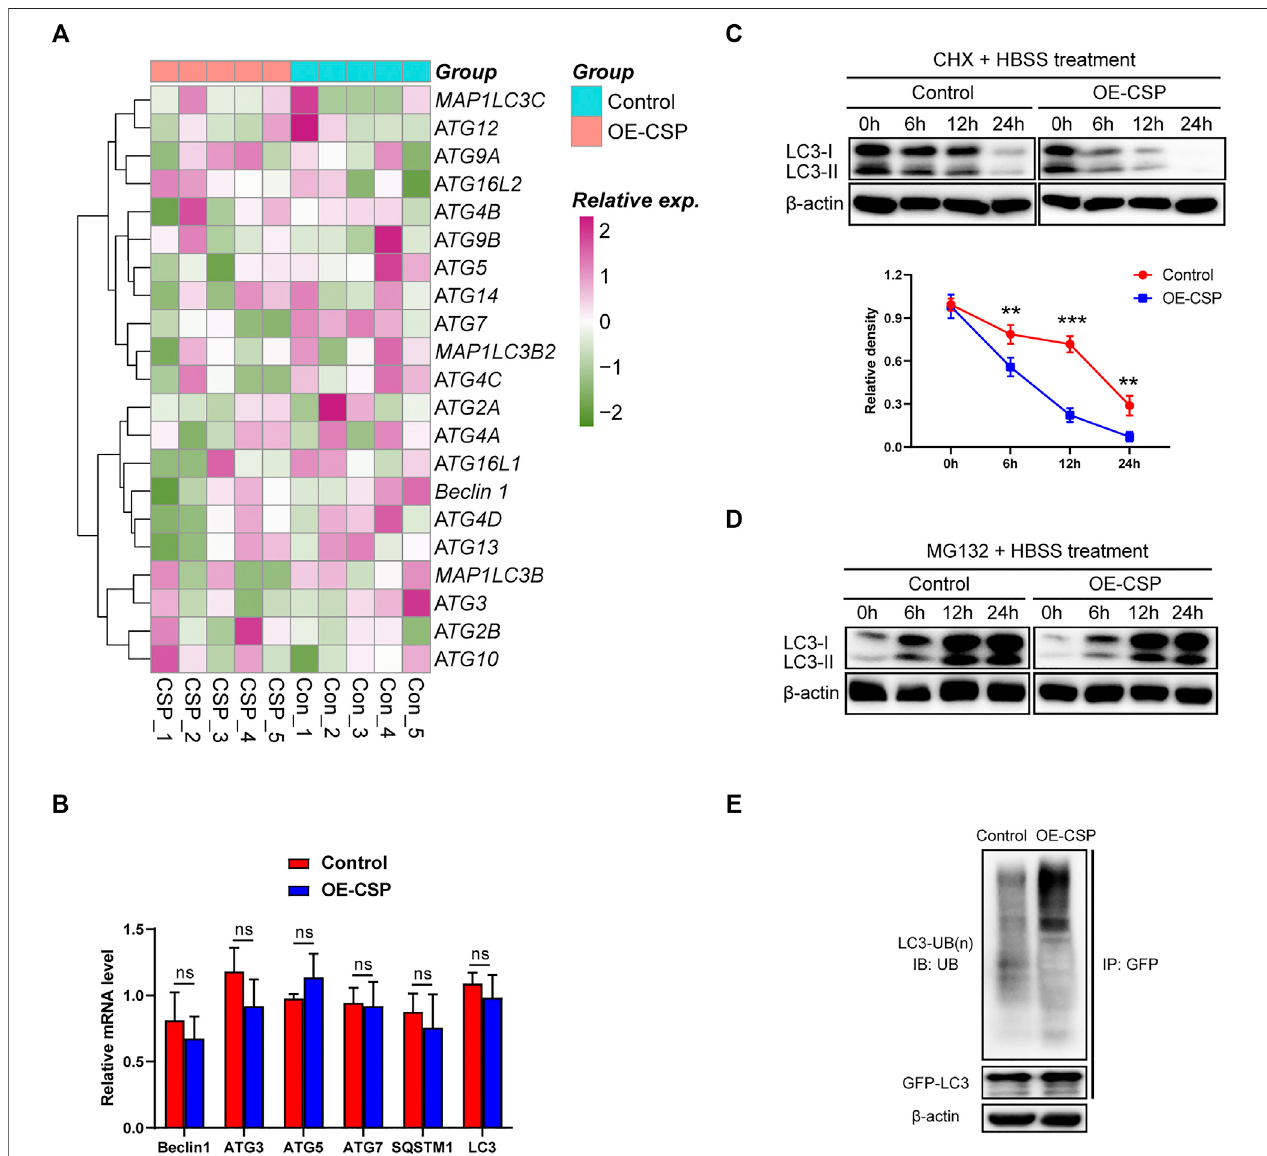
FIGURE 6 | Overexpression of CSP promotes proteasomal degradation of LC3B. (A) Control and OE-CSP A549 cells (1 × 10 6 ) were seeded in 6-well plates and treated with HBSS. They were then lysed with TRIzol buffer and transcriptome sequencing was performed. (B) The mRNA level of the autophagy- related proteins was con fi rmed using quantitative real-time polymerase chain reaction (C) Control and OE-CSP A549 cells were treated with cycloheximide and the protein was collected 0, 6, 12, and 24 h later. The LC3B protein level ( up ) was then detected and the half-life period ( down ) was analyzed. (D) After treatment with MG132 for 0, 6, 12, and 24 h, the LC3B protein level was detected using Western blotting. (E) Control and OE-CSP A549 cells (1 × 10 6 ) were transfected with GFP-LC3B plasmid; they were then lysed with Western lysis buffer and the GFP-LC3B protein was puri fi ed using a Capturem IP & Co-IP kit. The ubiquitin level was detected. The data are presented as the mean ± standard deviation of three independent experiments in vitro (ns, not statistically signi fi cant, * p < 0.05, ** p < 0.01, and *** p < 0.001).